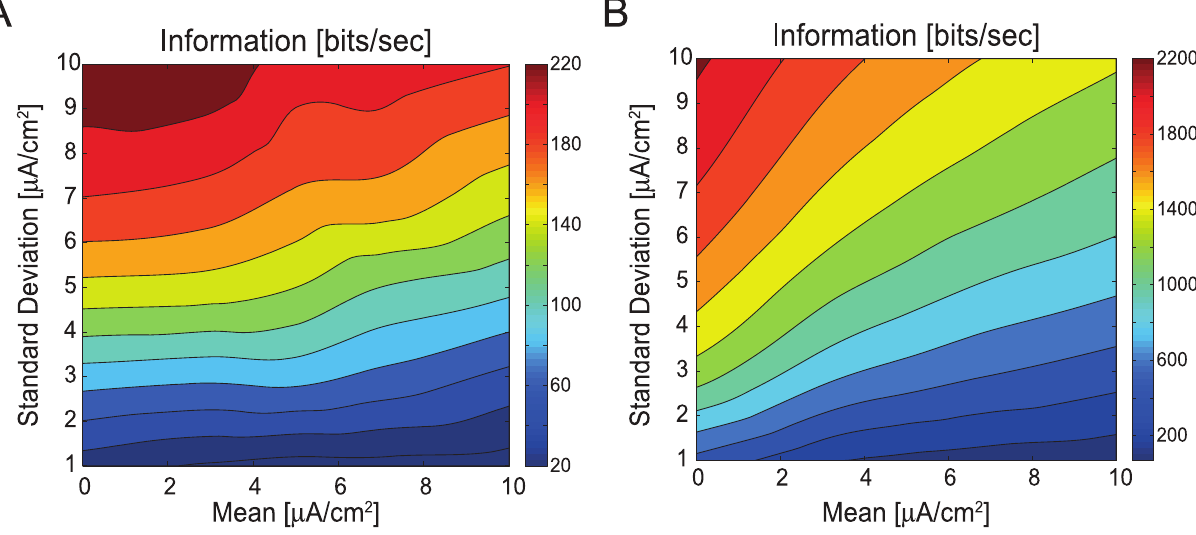
Figure 2. Information encoding in the spiking and graded neuron models. A. Information rates (bits s 2 1 ) of the spiking neuron model evoked by white noise current stimuli with different means and standard deviations. B. Information rates (bits s 2 1 ) of the graded neuron model evoked by the same white noise current stimuli as in A.